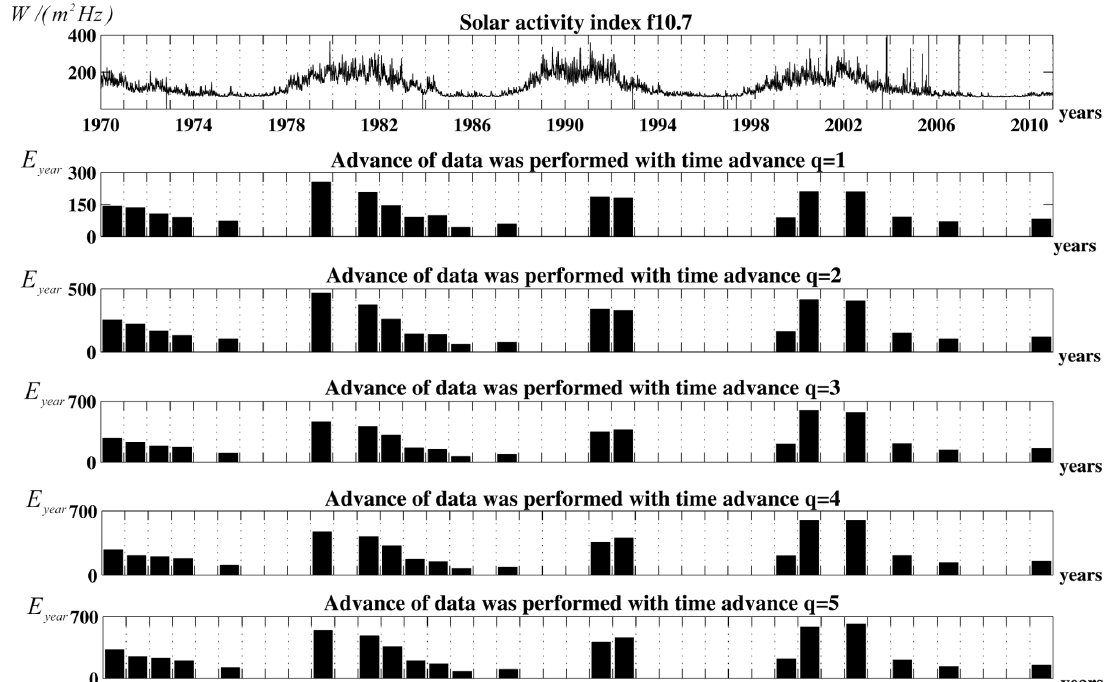
3 ∑ = K ∑ ( a l ) 2 values are indicated on the axes oy, K =384 is the num- year j , k k =1 l =1